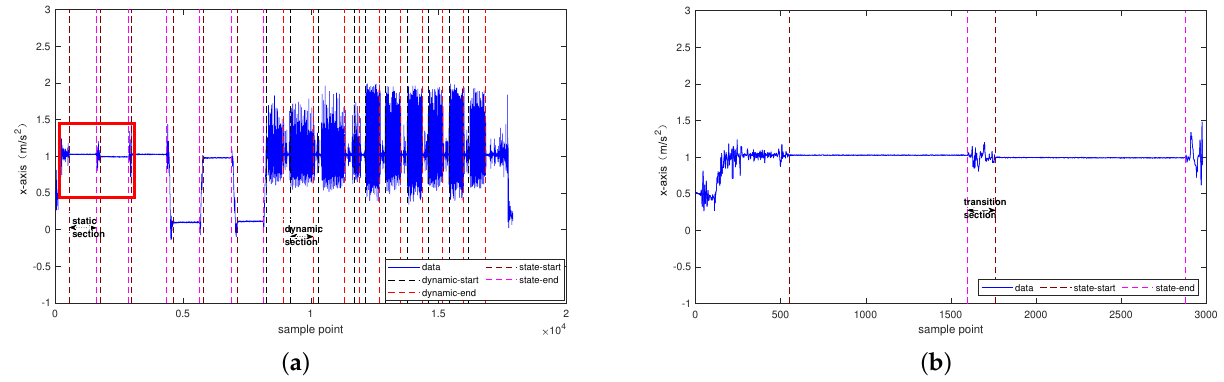
Figure 5. ( a ) Basic action segmentation sketch. ( b ) Traditional action segmentation